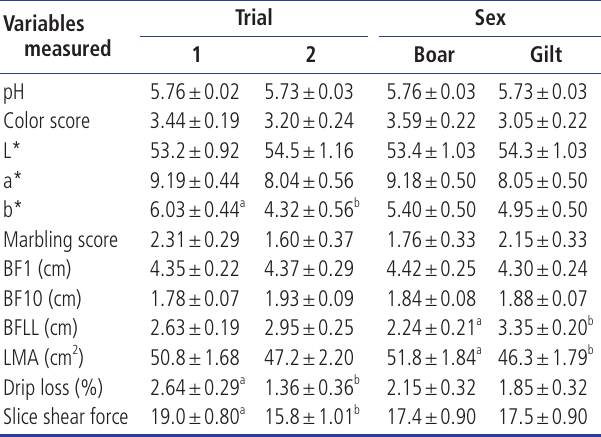
L*, indicates muscle lightness; a*, a measure of muscle redness; b*, a measure of muscle yellowness; BF1, 1st rib backfat; BF10, 10th rib backfat; BFLL, last lumber backfat; LMA, loin muscle area. a,b Means with different superscripts among groups within each variables meas- ured differ at